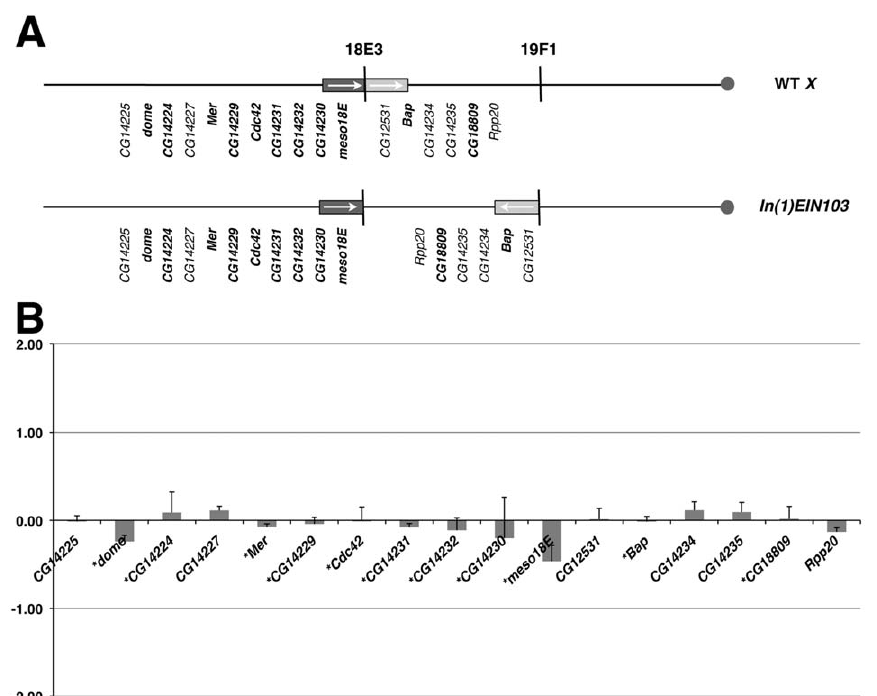
Figure 3. Disrupting an embryo gene expression neighbourhood. (A) In(1)EIN103 disrupts an embryo neighbourhood at 18E; the genes in the neighbourhood and their location in the wild type and inverted chromosomes is indicated. (B) Graph of gene expression ratios from a microarray comparison of In(1)EIN103 and its uninverted progenitor. The y -axis represents log2 expression ratios.